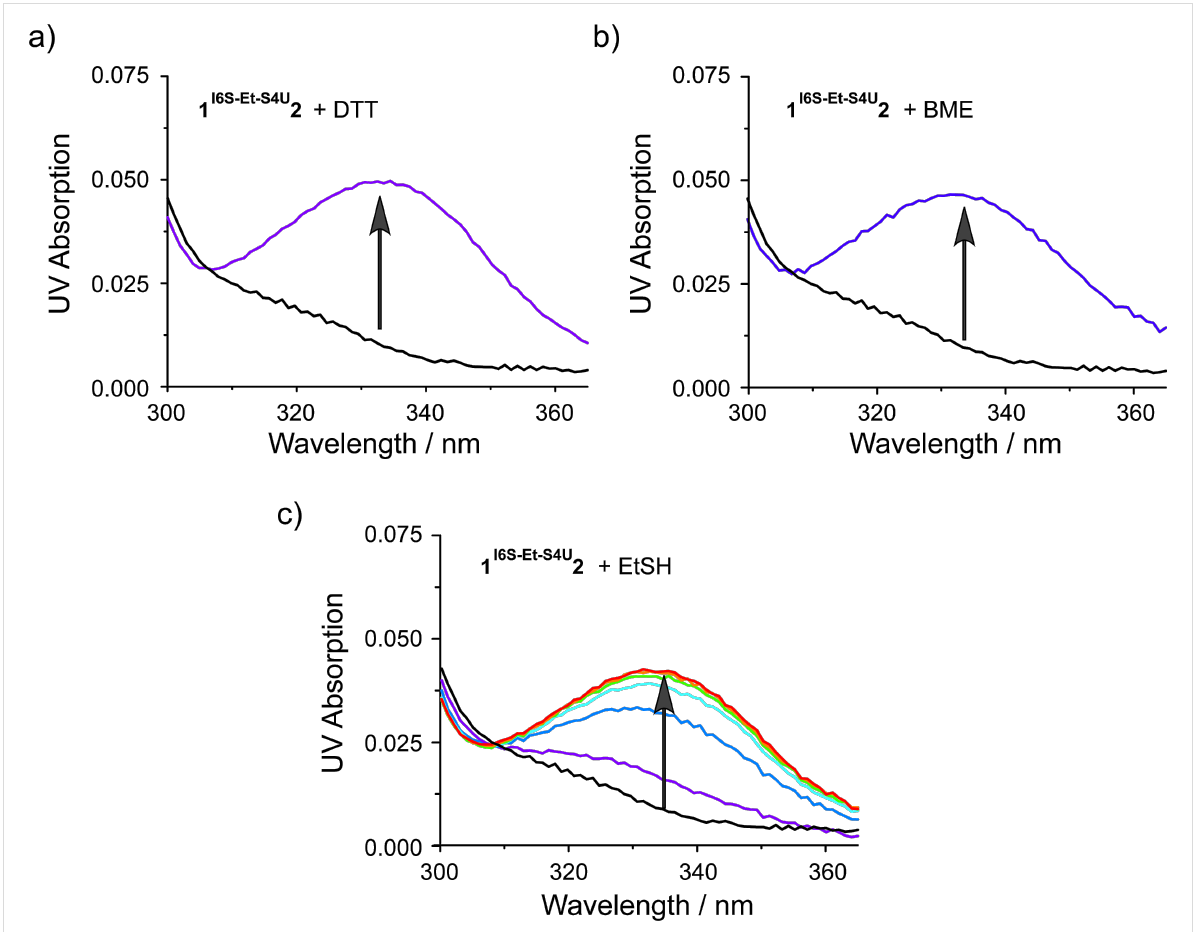
Figure 5: UV time course of opening of the cross-link in duplex 1 I6S-Et-S4U 2 with the thiol nucleophiles DTT (a), β -mercaptoethanol (BME, b) and ethanethiol (EtSH) (c). Upon removal of the linker, the thionucleobase absorption bands above 300 nm are restored. Black, no nucleophile; purple, 0 min; blue, 5 min; cyan, 10 min; green, 15 min; orange, 20 min; red, 25 min.